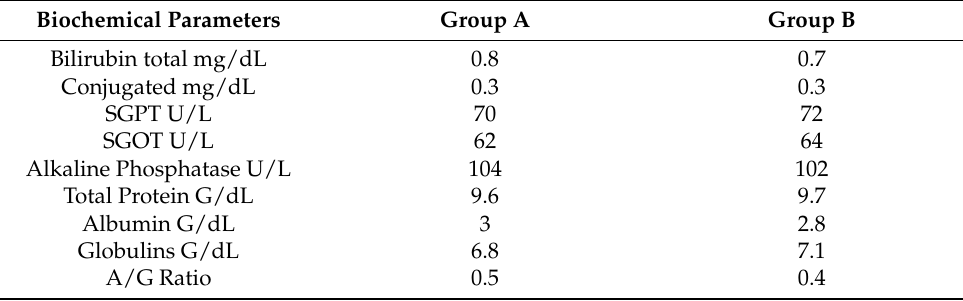
Table 7. Blood biochemical analysis of control and tested groups of